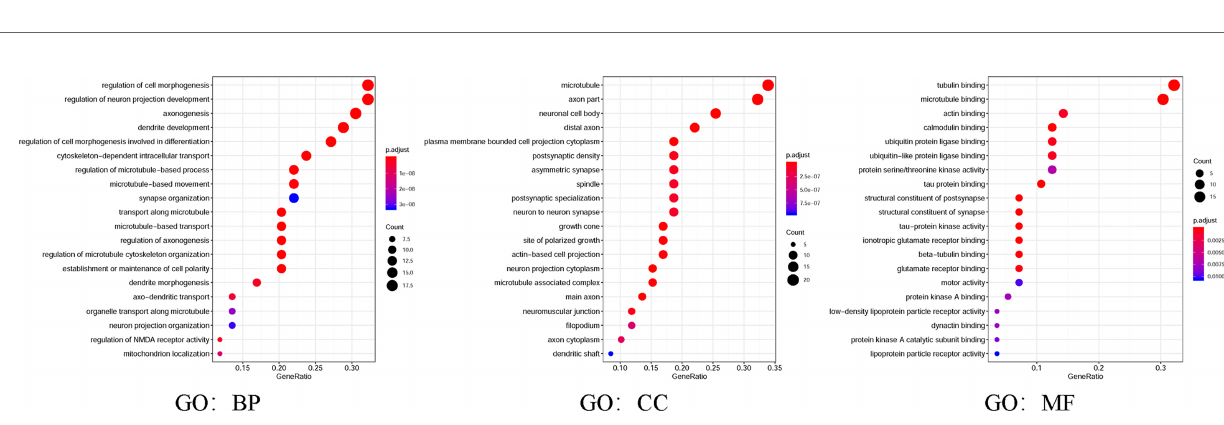
FIGURE 8 | Gene Ontology (GO) was utilized to analyze the expected functions of MAP mutations and their 50 frequently altered neighbor genes via the DAVID dataset. Starting from the three directions of biological processes (GO: BP), cell components (GO: CC), and molecular functions (GO: MF), the expected functions of target gene mutation can be predicted and analyzed. DAVID, Database for Annotation, Visualization, and Integrated Discovery; MAP, microtubule-associated